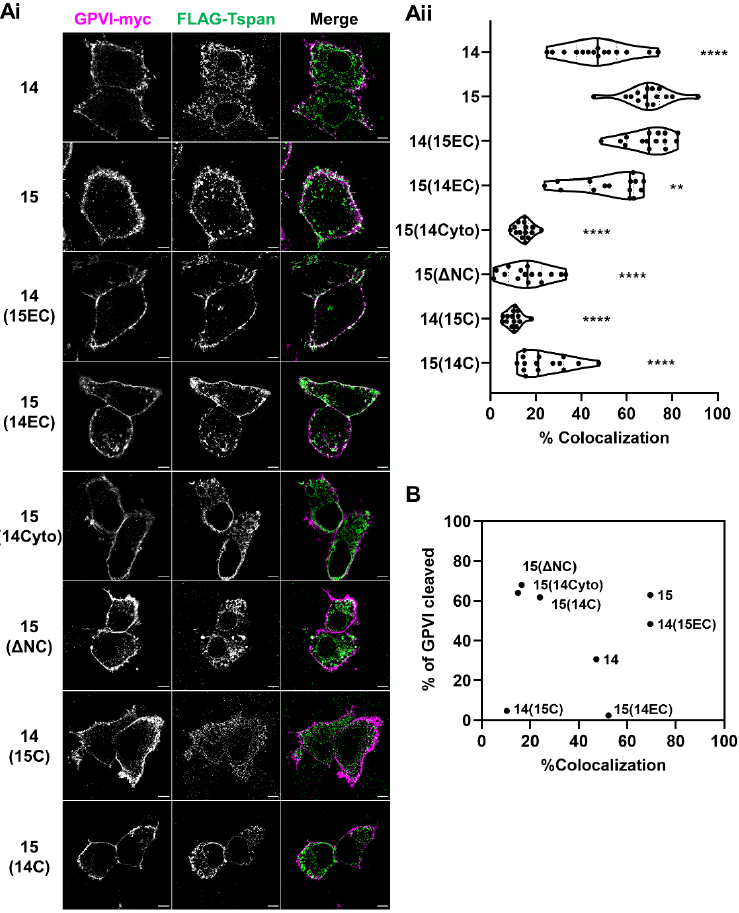
Figure 5. The capacity of Tspan15 wild-type and mutant forms to promote GPVI cleavage is unrelated to the extent to which they co-localise with GPVI. Tspan14/15/33 triple knockout HEK-293T cells were transfected with expression constructs for C-terminally Myc-tagged GPVI, FcR γ , ADAM10 and FLAG-tagged Tspan14 or 15 chimeras that are described in detail in Figure 4A. Cells were fixed and stained with anti-Myc (GPVI–Myc, magenta) and anti-FLAG (FLAG-Tspan, green) antibodies. ( Ai ) The middle planes of the cells were imaged using Airyscan confocal microscopy in super-resolution mode (scale bar 5 μ m). No signal was detected in either channel in the empty vec- tor-transfected cells (data not shown). ( Aii ) The degree of co-localization between GPVI–Myc and FLAG-TspanC8s is presented as the percentage of co-localizing pixels in the GPVI–Myc (magenta) channel. Data are representative of 15 fields of view from three independent experiments and are normalized by arcsine transformation before being statistically analyzed by a one-way ANOVA, followed by Dunnett’s multiple comparison tests, compared to cells transfected with wild-type Tspan15 (**, p < 0.01; ****, p < 0.0001). ( B ) Scatter plot summarising the relationship between degree of co-localization, expressed as the average of data presented in panel Aii , and percentage of GPVI cleaved, expressed as mean of the quantitation presented in Figure 4B.